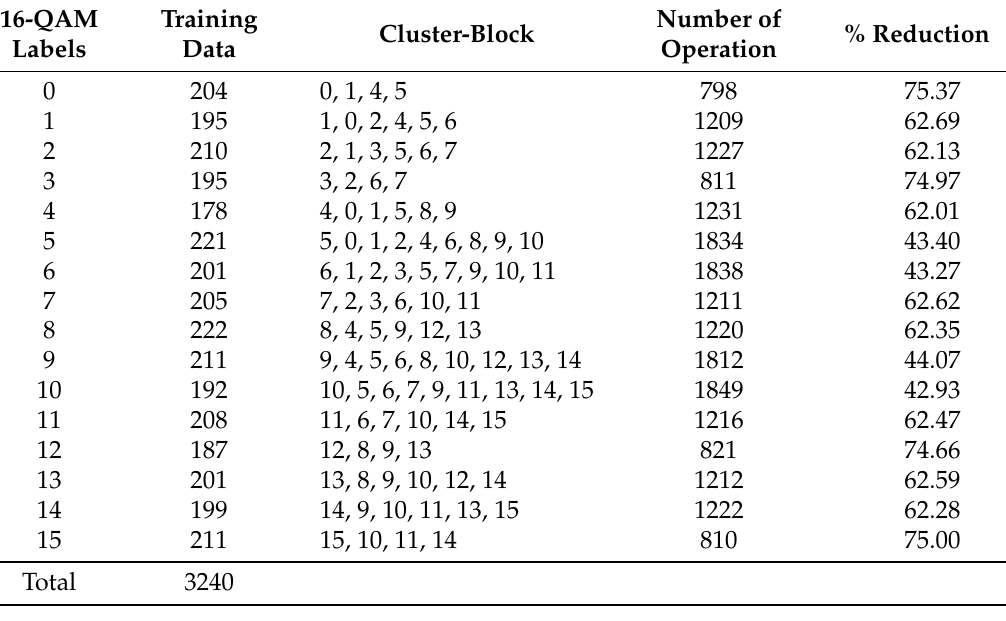
Table 1. Reduction of operations using the modified KNN algorithm. The table shows the application of the cluster-blocks on the real data of the experimental setup.